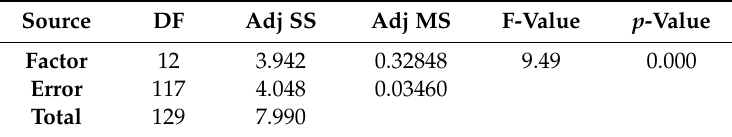
Table 2. Analysis of variance for flexural modulus.